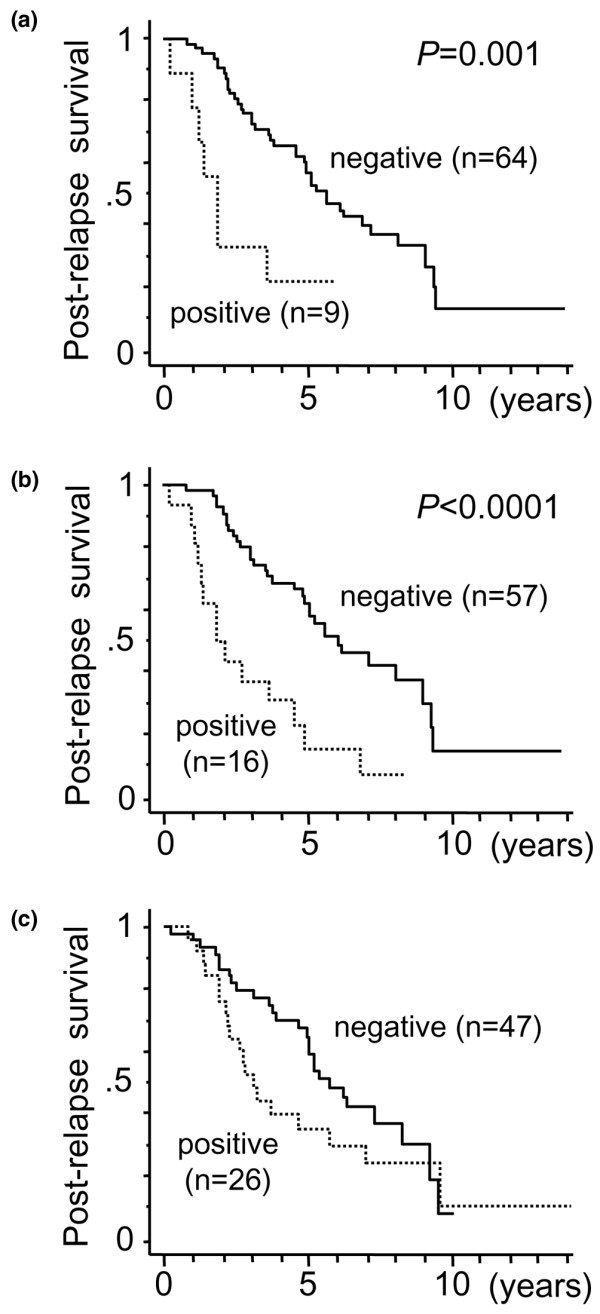
Post-relapse survival according to HER2 overexpression, p53 protein accumulation, and Ki67 expression. (a) Post-relapse survival according to HER2 overexpression. (b) Post-relapse survival according to p53 protein accumulation. (c) Post-relapse survival according to Ki67. HER2 overexpression and p53 protein accumulation significantly reduced post-relapse survival.